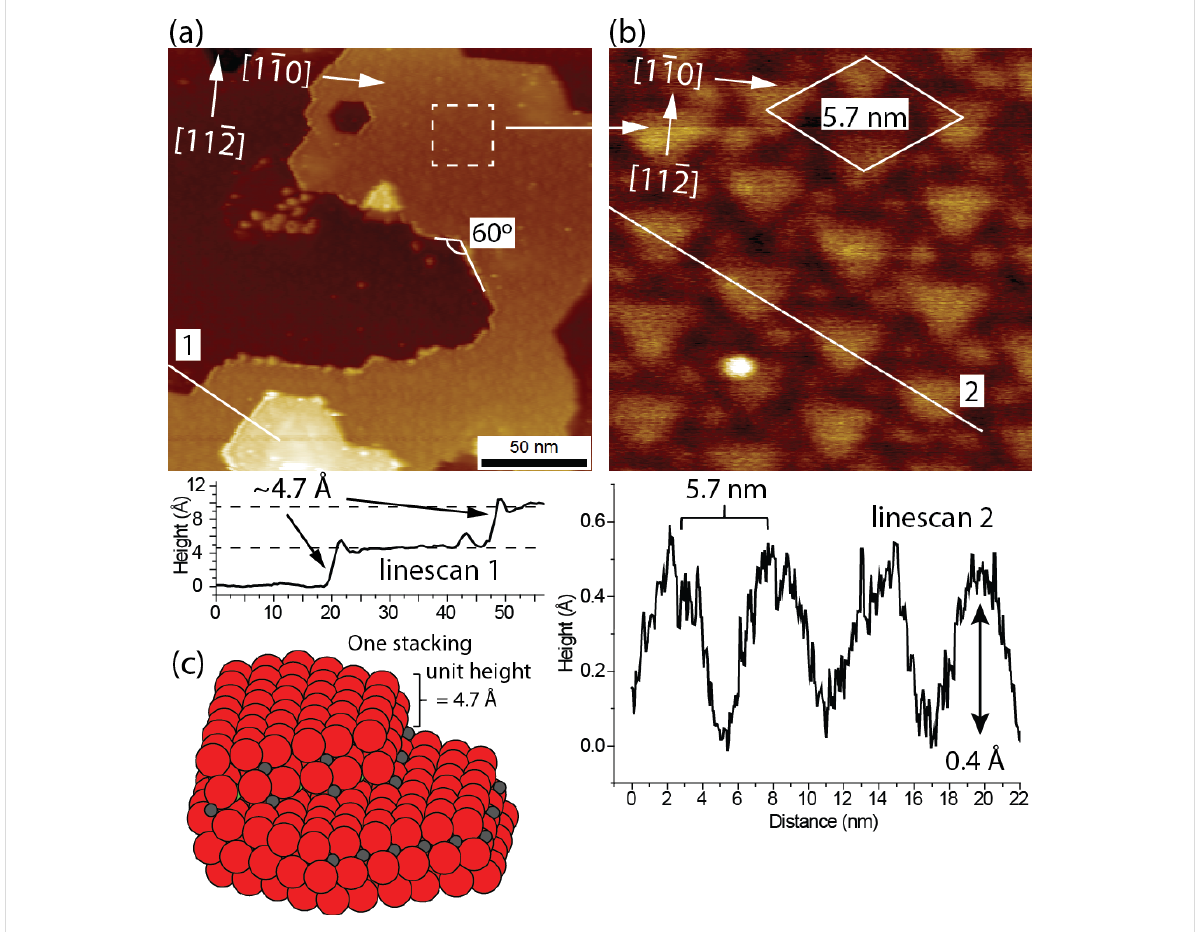
Figure 2: Experimental NC-AFM images recorded on the MgAl 2 O 4 (111) surface prepared by sputtering and annealing in oxygen (1150 °C, p(O 2 ) = 1 × 10 − 7 mbar). (a) Large-scale NC-AFM image (200 × 200 nm 2 ) of the surface ( ∆ f set = − 15 Hz, U bias = − 8.5 V, A p–p = 10 nm) showing step edges forming 60° angles. The graph for line scan 1 reflects the corrugation of a step. The position of the line scan is indicated in the image. (b) High-resolu- tion zoom-in on a terrace (20 × 20 nm 2 ), which shows a hexagonally ordered superstructure with a lattice parameter of 5.7 nm. The graph for